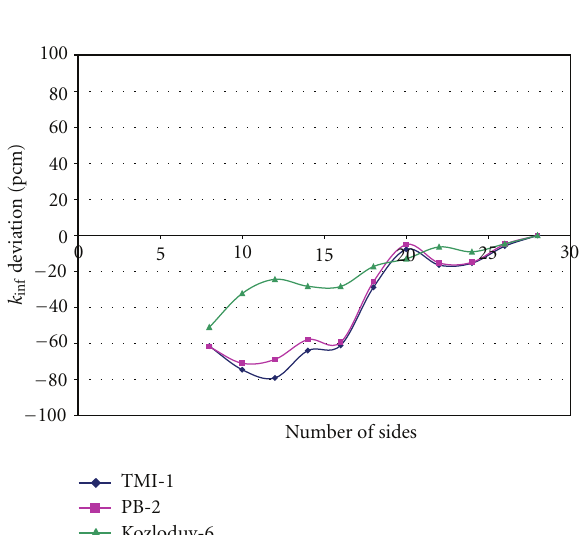
Figure 5: Number of polygon sides’ influence on k inf (3 ×